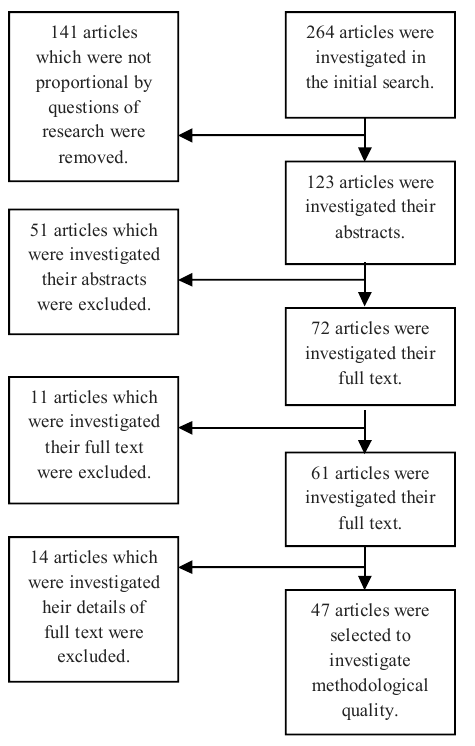
Fig. 3. Process of selecting appropriate articles in the field of